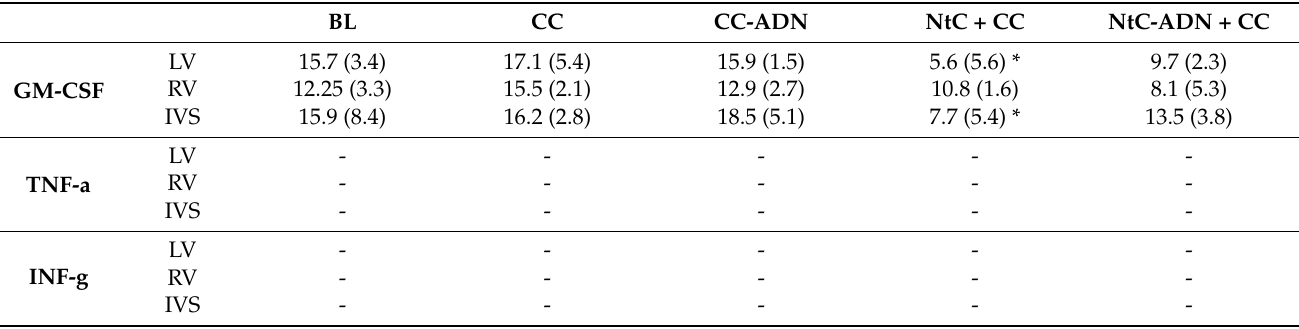
Table 1. Cytokines, chemokines and mediators of wound healing and tissue